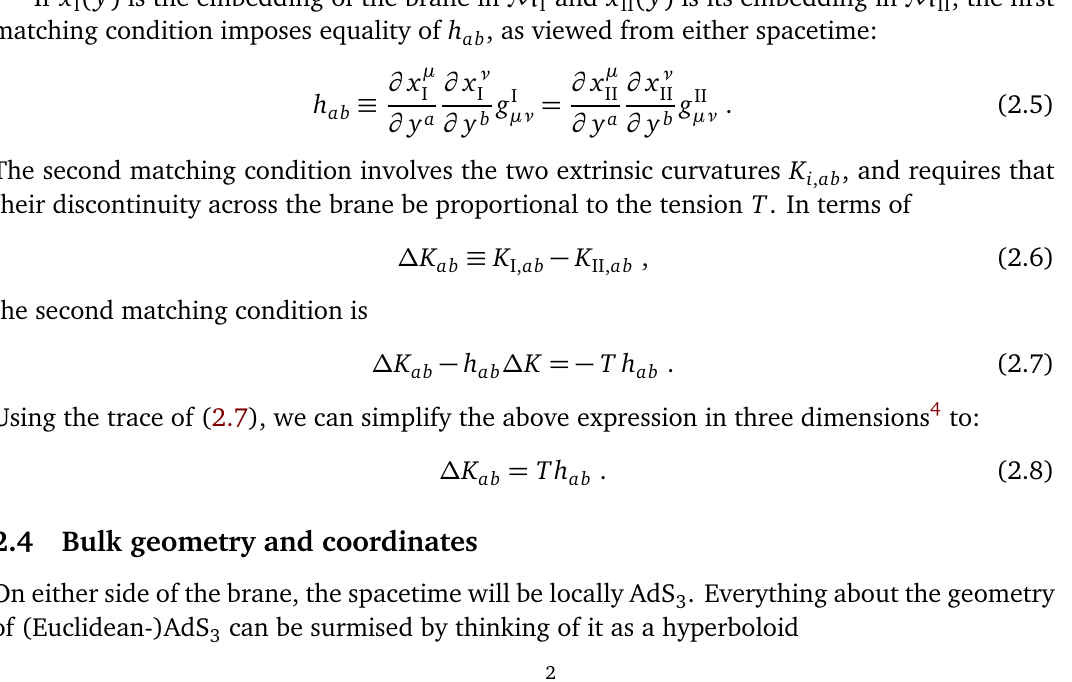
Figure 3: The bulk geometry for a linear defect in AdS lines represent the brane, and the two spaces are glued with the Israel–Lanczos matching